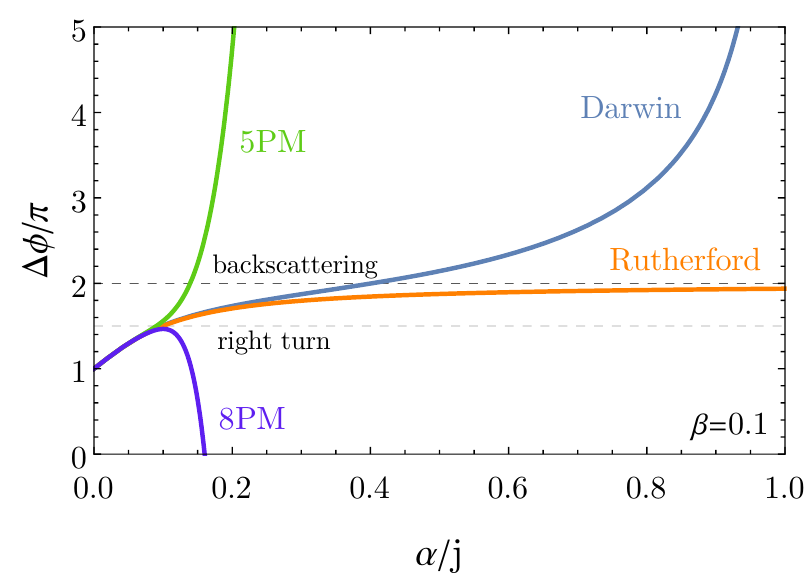
Figure 1 . Classical scattering angle ∆ ϕ vs. α/j for relativistic Coulomb scattering. The result from eq. (4.12) is shown in blue and labeled “Darwin”. We also show the Ruthrford scattering angle in orange, as well as the expansions of (4.12) to 5th and 8th orders in green and purple, respectively. We chose β = 0 . 1 for this plot. Note that unlike Rutherford scattering, our classical trajectory involves winds around the origin for α/J & 0 . 4